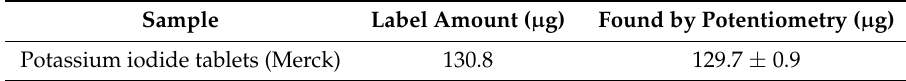
Table 5. Determination of iodide in pharmaceutical